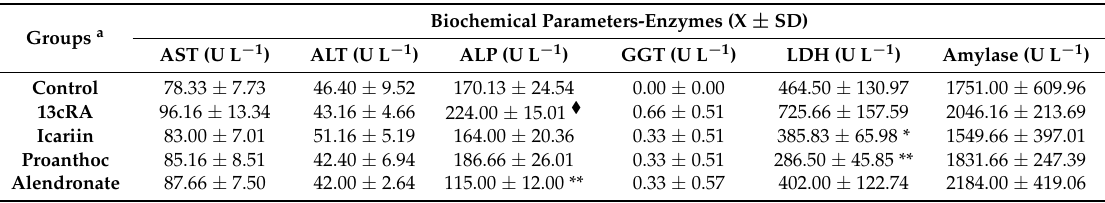
Table 1. Effect of icariin, proanthocyanidins and alendronate on enzymatic biochemical parameters in blood in rats with retinoic acid-induced bone loss. Groups a